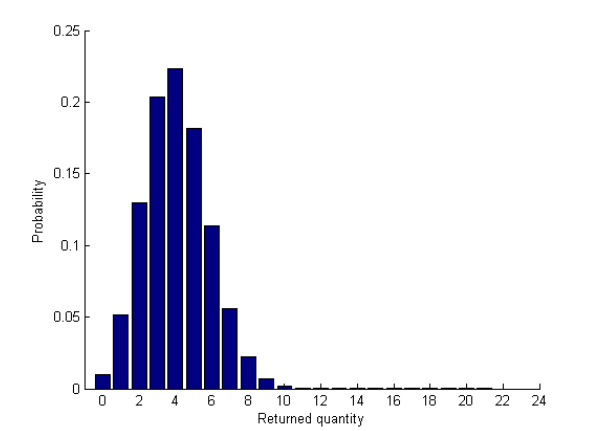
Figure 1. Probability distribution for returned quantity in the